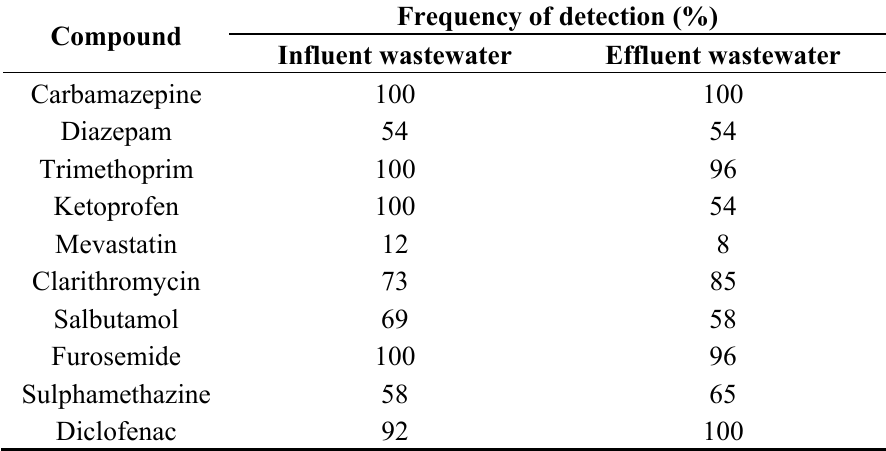
Table 3. Examples of pharmaceutical emerging contaminants (ECs) detected in influent and effluent wastewater of wastewater treatment plants (adapted from [77]).